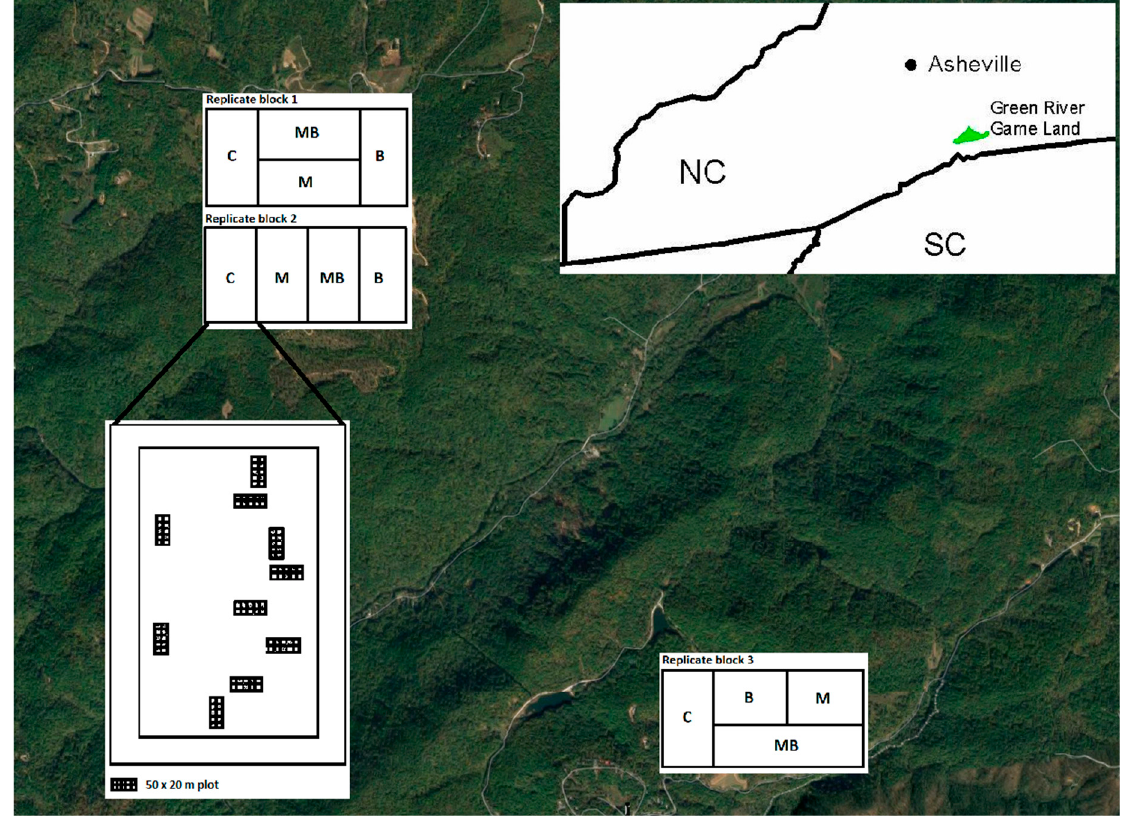
Figure 1. The treatment layout at Green River Game Land was a randomized complete block design: with 3 treatment areas, 4 treatments in each area (control = C, burned = B, mechanical removal of stems <10 cm in diameter at breast height (DBH)= M, and mechanical removal of stems <10 cm DBH + burned = MB), 10 plot origins in each area, 10 subplots in each origin, and two 1 m 2 vegetation plots per subplot. The inset is a diagram that reflects the general layout of a treatment unit, and is not to scale.